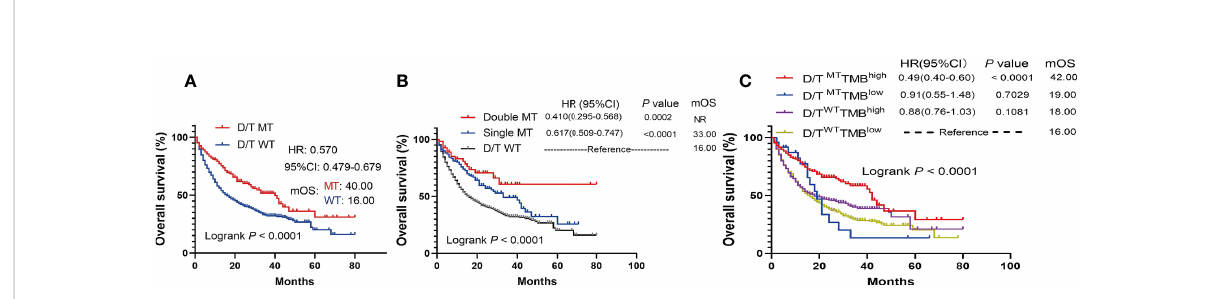
FIGURE 4 The survival signi fi cance of PTPRD/PTPRT mutation in ICIs-treated cohort (Samstein et al., n = 1556). (A) Association between PTPTD/PTRT mutation and OS in pan-cancer treated with ICIs. (B) Effect of PTPRD/PTPRT single mutation versus co-mutation on patients treated with ICIs. (C) Survival analysis was performed based on PTPRD/PTPRT mutation status and TMB